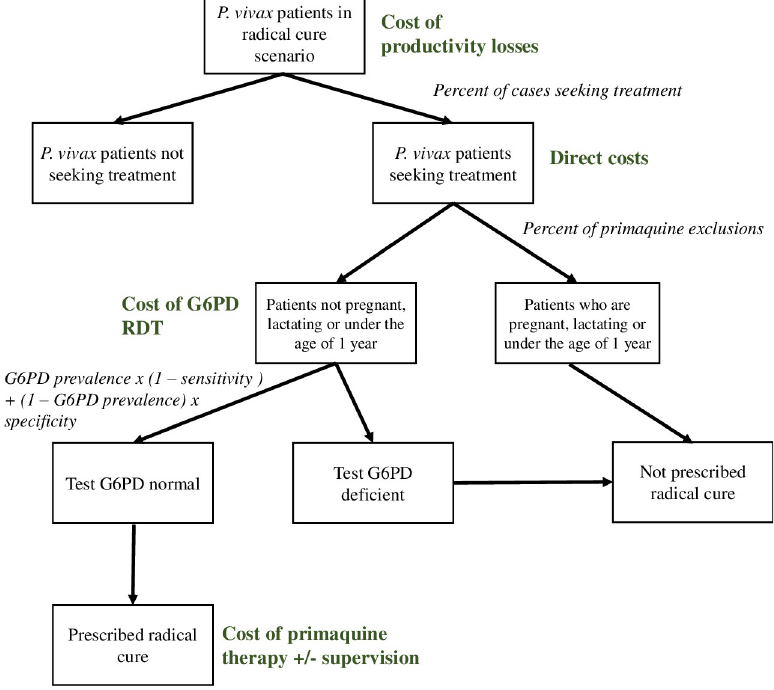
Fig 1. Flow diagram for the application of costs in the radical cure scenarios. Of those prescribed radical cure, only those who are G6PD normal are able to have an effective dose.